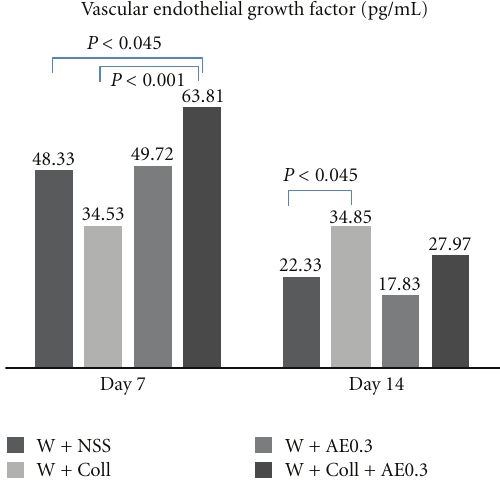
Figure 7: Tissue VEGF (pg/mL) of each group was determined on days 7 and 14 in the W-NSS, W-Coll, W-AE, and W-Coll-AE groups.